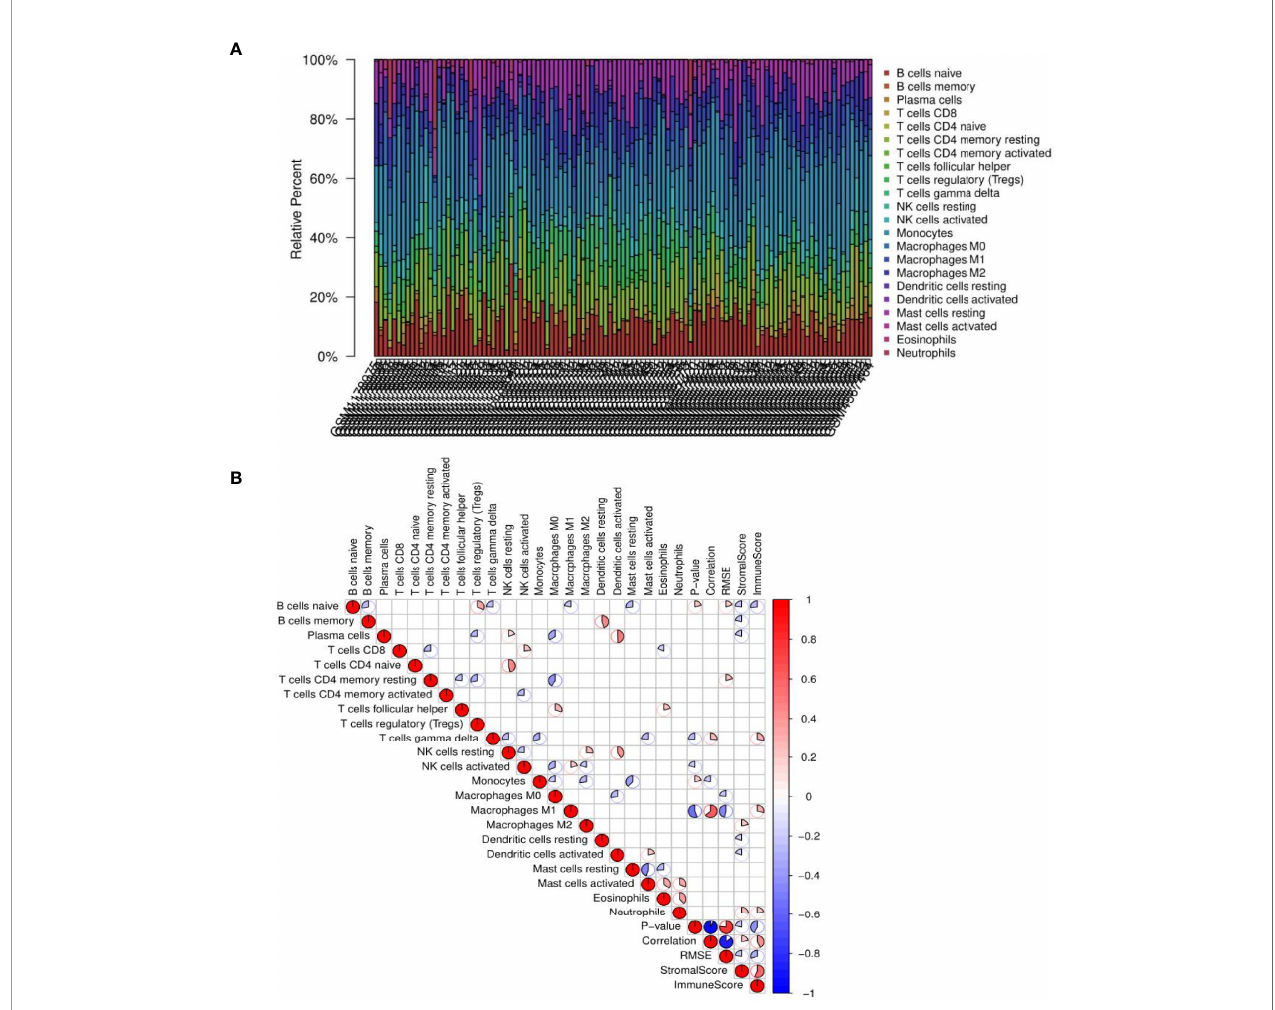
FIGURE 9 | Results of immune cell in fi ltration. (A) Relative percentages of immune cells in each non-alcoholic fatty liver disease (NAFLD) sample. (B) Correlation coef fi cient heatmap for the visualization of the prevalence of immune cell interactions in the immune microenvironment of NAFLD patient liver tissues. The heatmap shows the associations among 22 immune cell populations. The color red represents positive associations, and the color blue represents negative associations. The size of the sector area of each grid represents the size of the correlation coef fi cient. The darker and more signi fi cant the grid, the stronger the correlation between the corresponding horizontal and vertical objects of the grid. Blanks in the graph indicate that the P-value had not reached the threshold, and the color is marked only when the P-value was less than